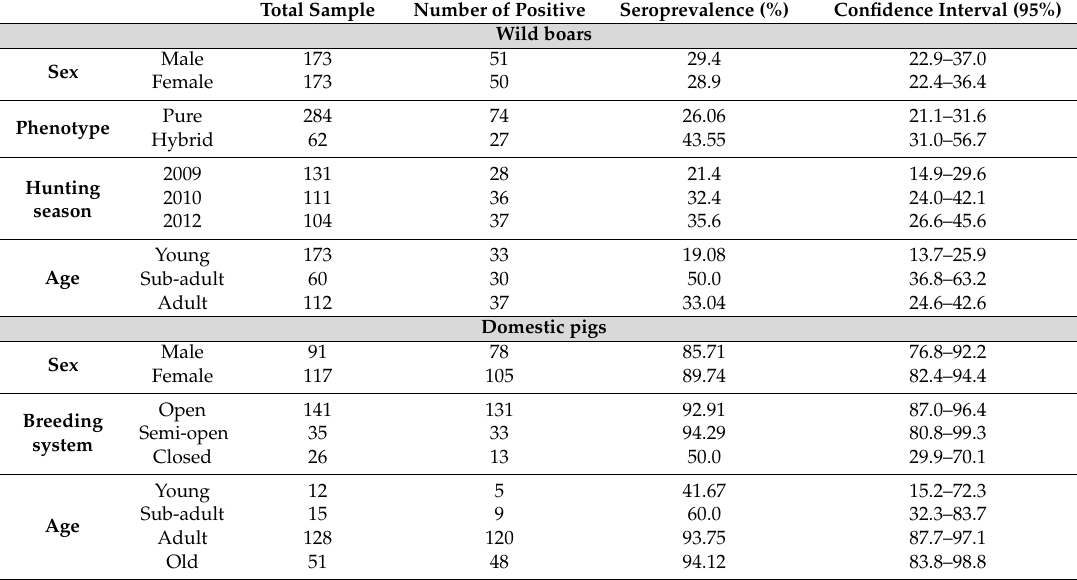
Table 1. HEV apparent seroprevalence percentages in domestic pigs and wild boar by gender, breed, hunting season and